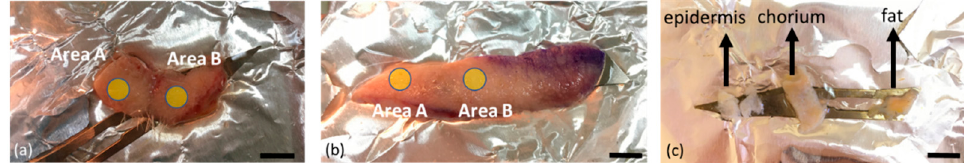
Figure 1. Indicative human skin tissue from ( a ) scalp (Sample 2) and ( b ) eyelids (Sample 4). Shaded regions indicate the individual areas measured on each sample. Panel ( c ) shows Sample 1 after dissection for purposes of reference spectra acquisition. Scale bar shows 0.6 cm.